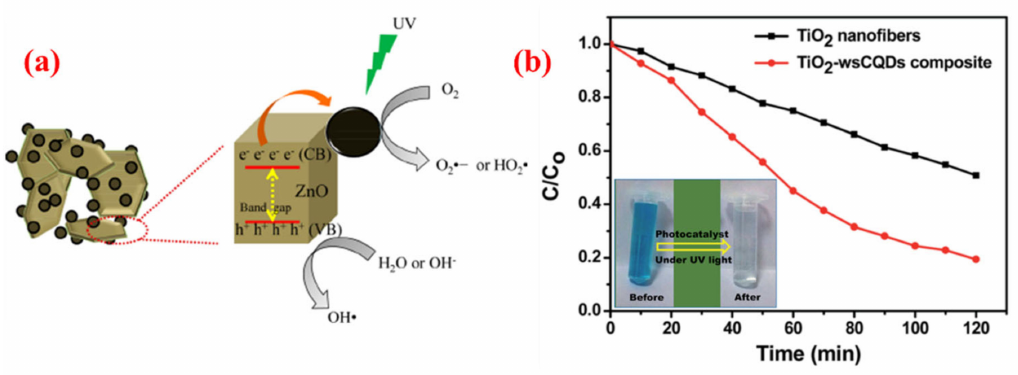
Figure 13. ( a ). Schematic presentation of the photocatalytic process of C-dots / ZnO composite [59]; ( b ). Photocatalytic degradation of MB in the presence of TiO 2 nanofibers and TiO 2 –wsCQDs composite under UV light irradiation (The inserted picture shows the color of MB solution before and after degradation)